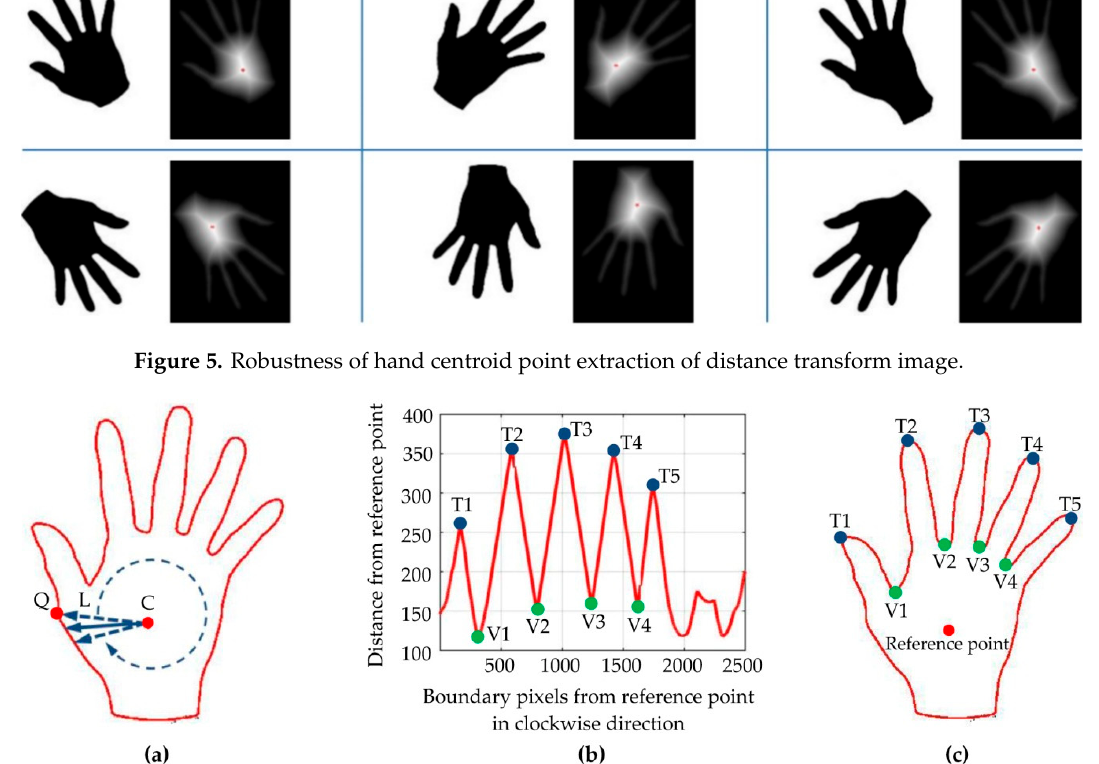
Figure 6. ( a ) Distance transform, ( b ) radius distance plot, ( c ) extracted fiducial points.